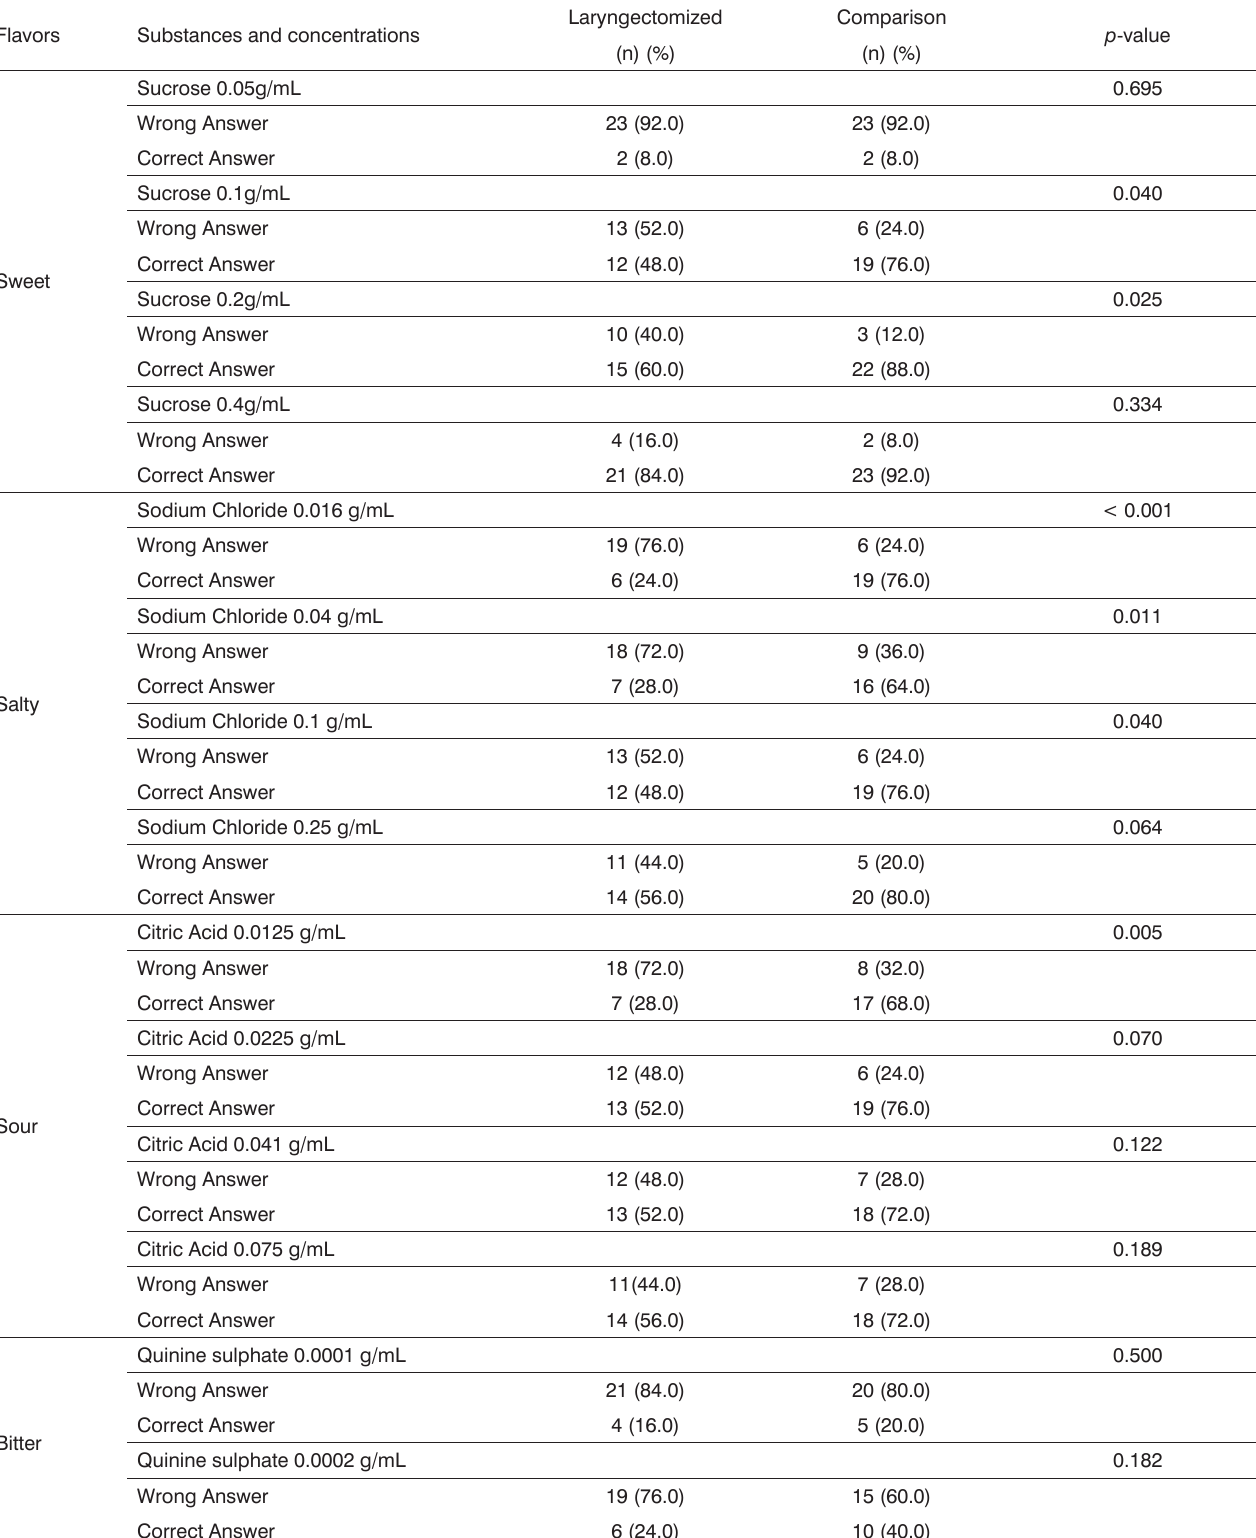
Table 3. Distribution of comparisons between the group of laryngectomized patients and the comparison group according to gustatory